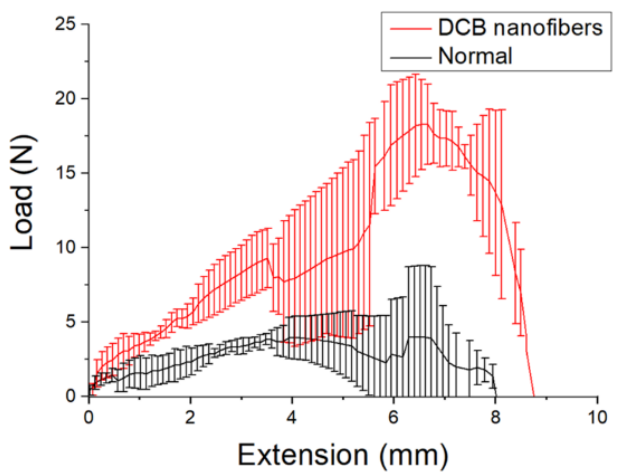
Figure 9. Tensile properties of normal tendons (maximum load-to-failure: 4.02 ± 4.74 N) and tendons repaired by the DCB – PLGA-composite nanofibers (maximum load-to-failure: 18.32 ± 2.69 N).